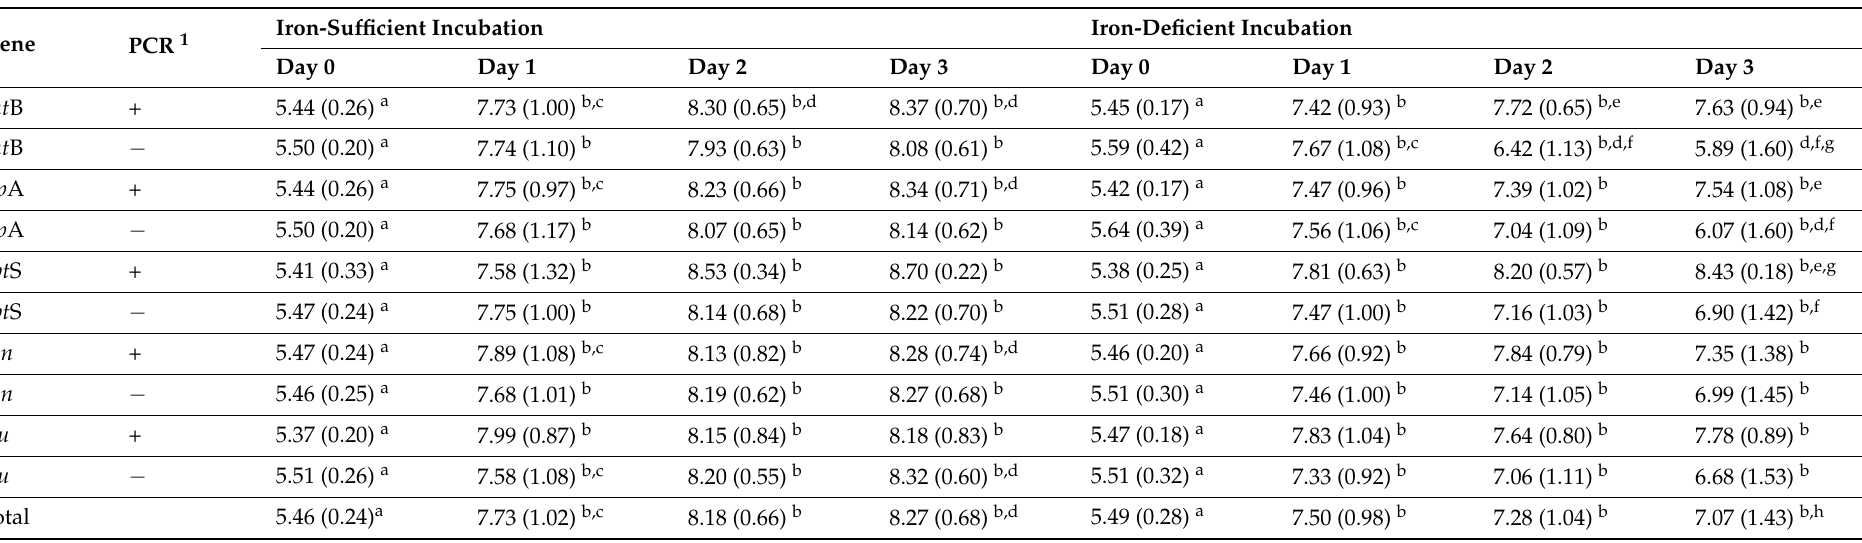
Table 2. Association between bacterial counts [means (standard deviations); log 10 colony-forming units/mL] and polymerase-chain-reaction (PCR)-positive iron-acquisition genes in Klebsiella pneumoniae isolates incubated in iron-sufficient and iron-deficient